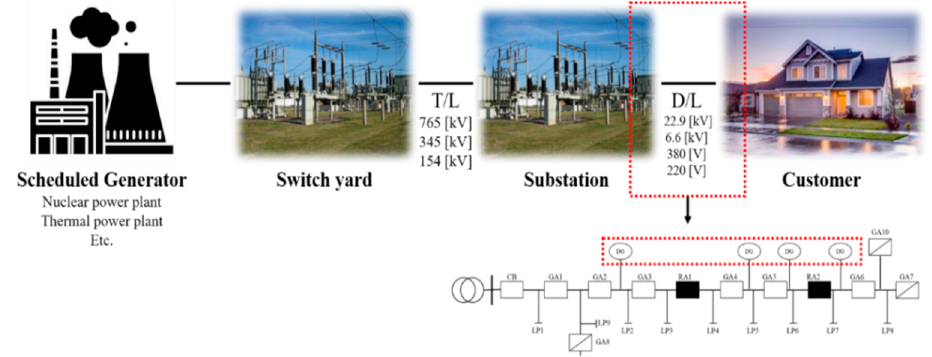
Figure 1. Overall power system scheme in South Korea.